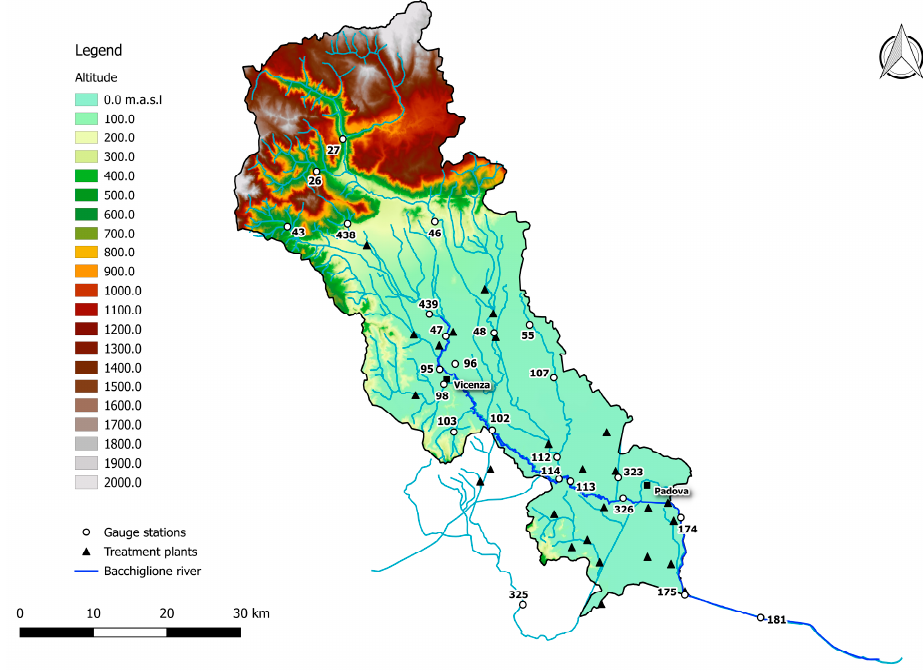
Figure 2. The Bacchiglione basin with gauge stations and treatment plants.